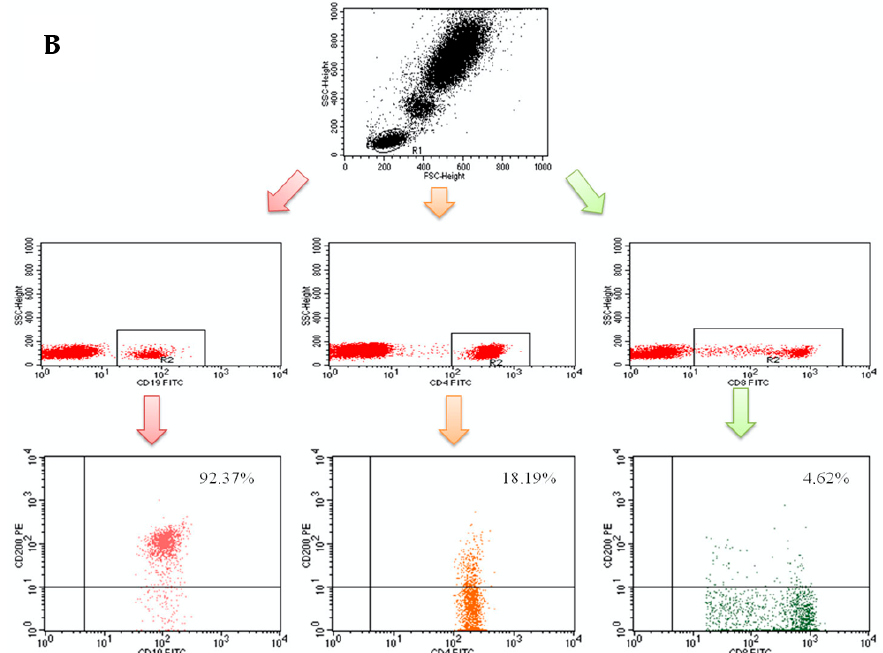
Figure 1. ( A ) Sample analysis of CD200 expression on B and T (CD4+ and CD8+) lymphocytes in idiopathic pulmonary arterial hypertension (iPAH) patients; ( B ) Sample analysis of CD200R expression on B and T (CD4+ and CD8+) lymphocytes in iPAH